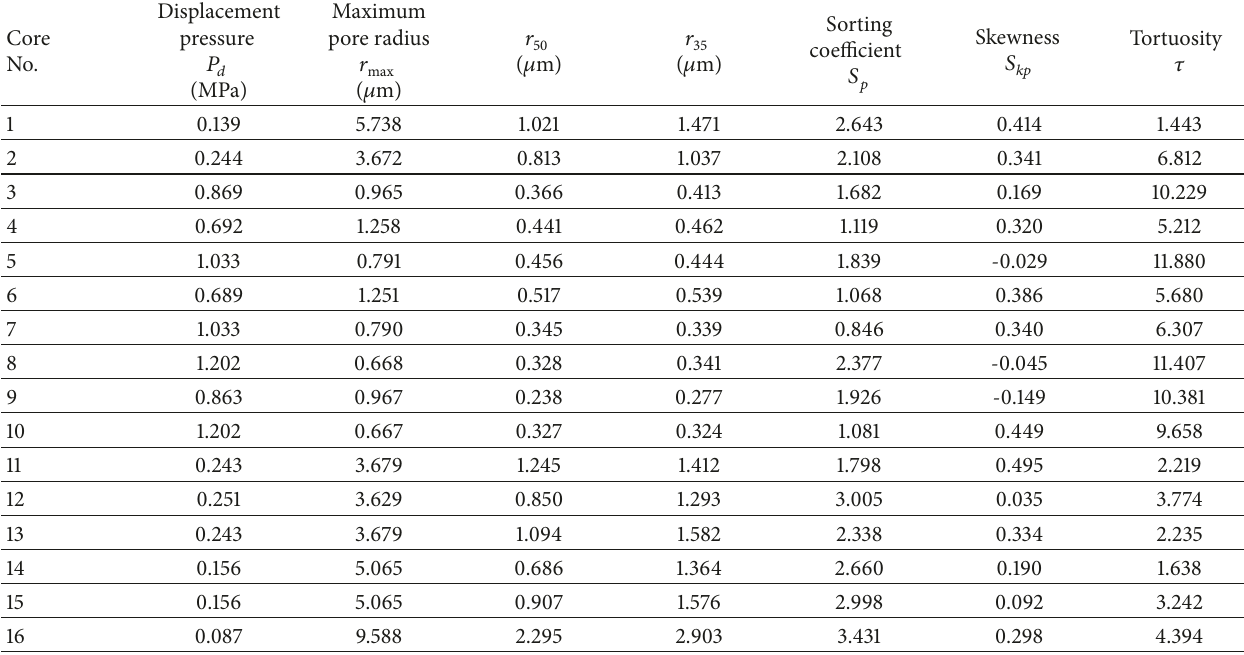
Table 2: Pore structure parameters of carbonate core samples obtained from HPMI test.